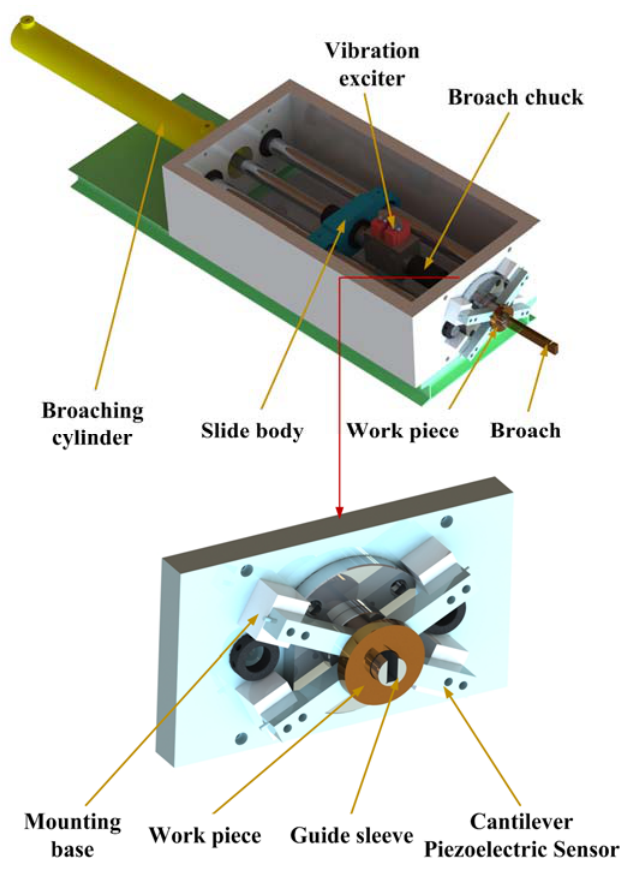
Figure 3. Schematic of the broaching system.